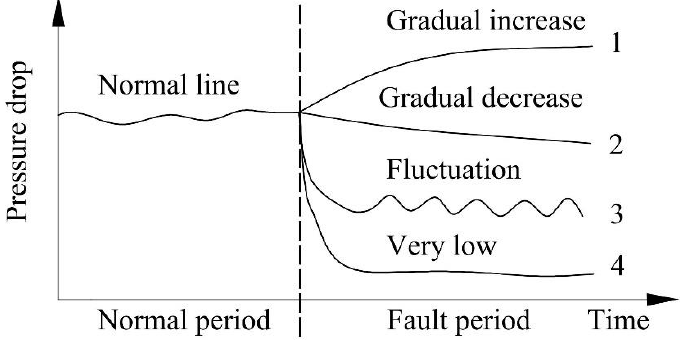
Figure 6. Time-varying characteristics of pressure drop of the cyclone separator.